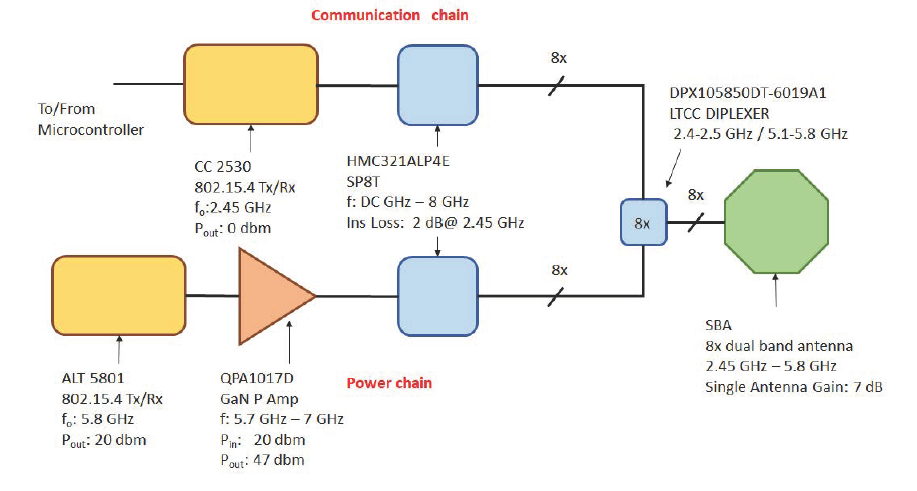
Figure 3. Energy Supplier node block